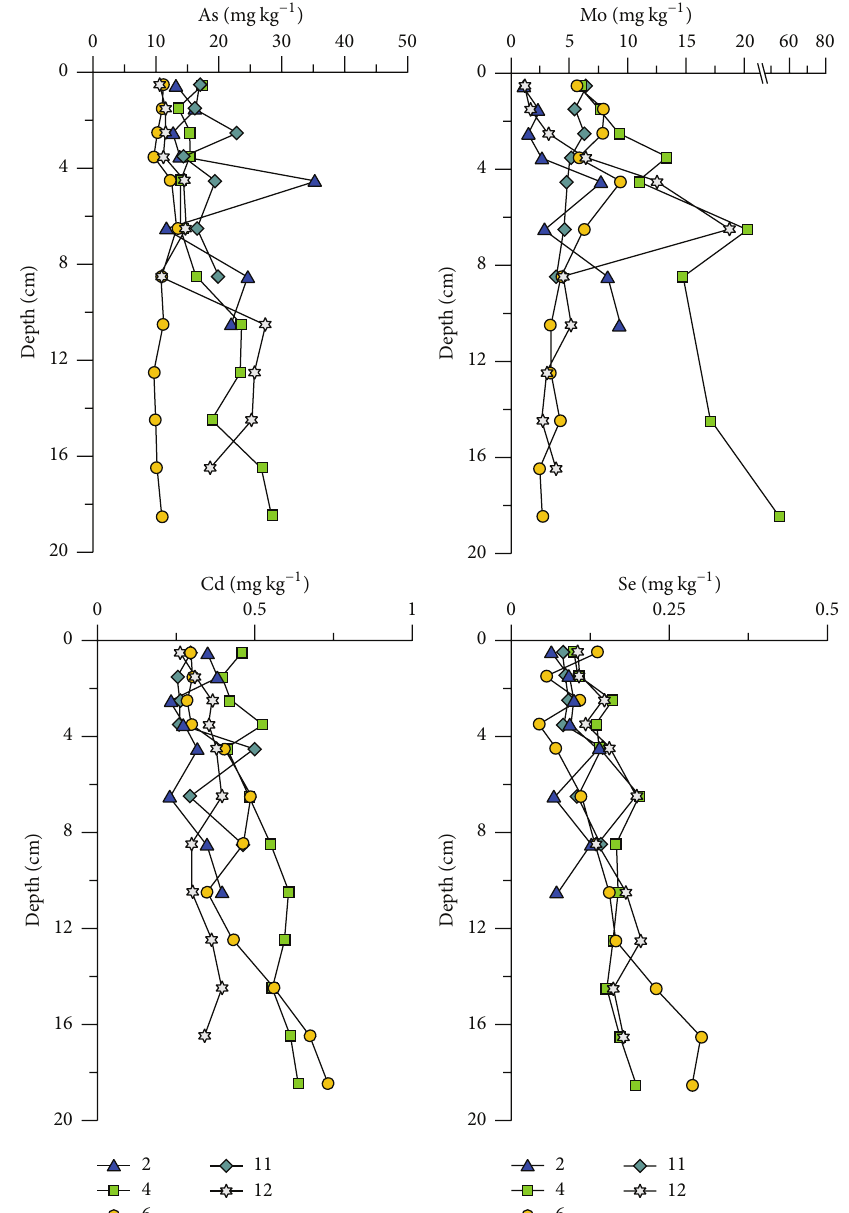
Figure 5: Depth profiles of concentrations of As, Mo, Cd, and Se (all expressed in mg kg −1 ) for lake Specchio di Venere sediment